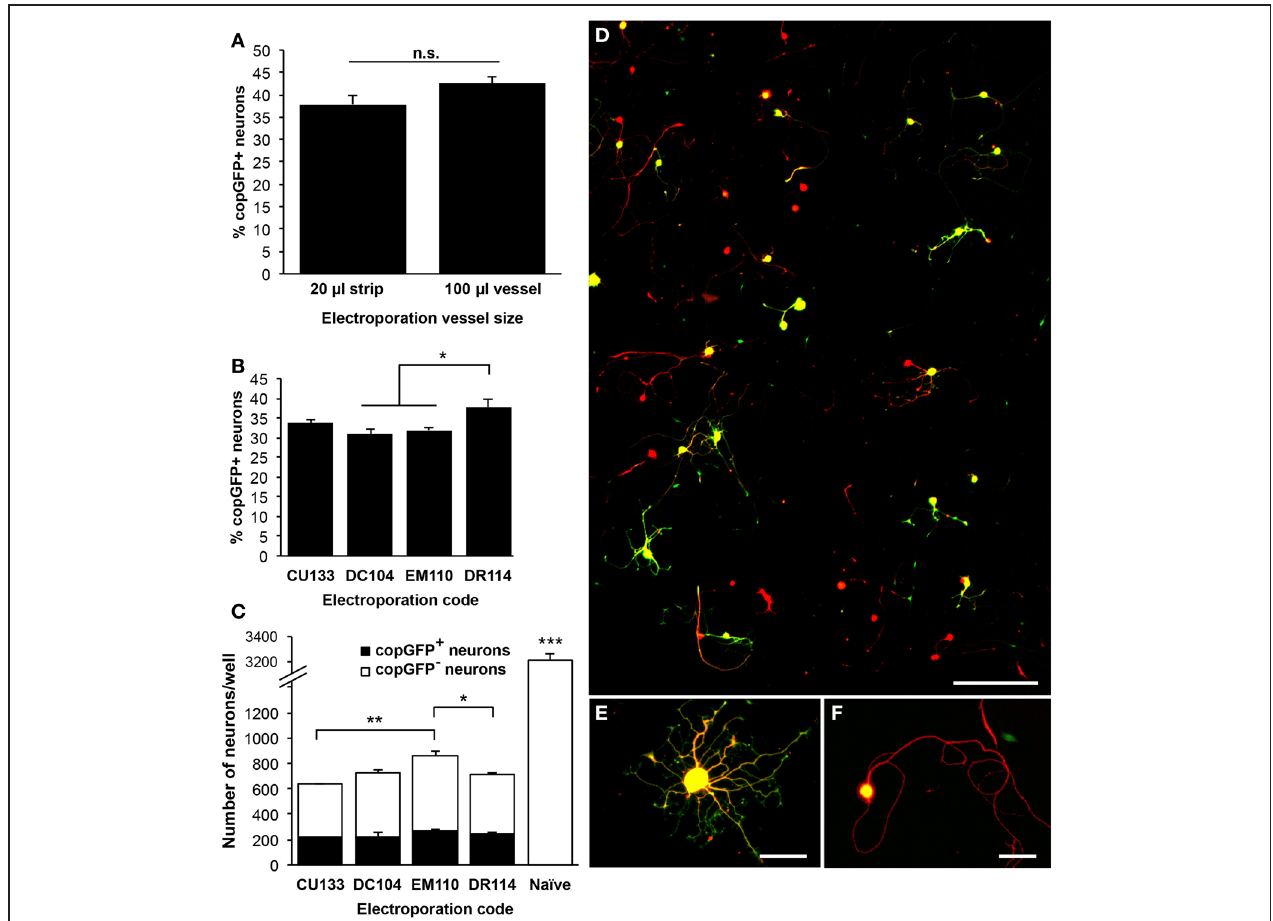
FIGURE 2 | Optimization of the 4D-Nucleofector electroporation code for transfection of adult dorsal root ganglion neurons. (A) Comparison of the 100 μ l cuvette and the 20 μ l well strip using code DR114 indicated a slightly higher transfection rate with the 100 μ l cuvette, but this difference did not reach statistical significance ( n = 4–5 wells across two independent experiments). (B) Five 4D-Nucleofector codes were compared using the 20 μ l well strips. DR114 consistently resulted in the highest transfection rate, measured 48h after electroporation ( n = 3–5 wells per condition; ANOVA p < 0 . 001). CU110 did not result in any transfected neurons (not shown). (C) For the four codes that resulted in successful transfection, total neuronal survival rates were examined. CU133 exhibited the most neuronal death, and EM110 produced the highest total neuronal survival rate. Compared to naïve,